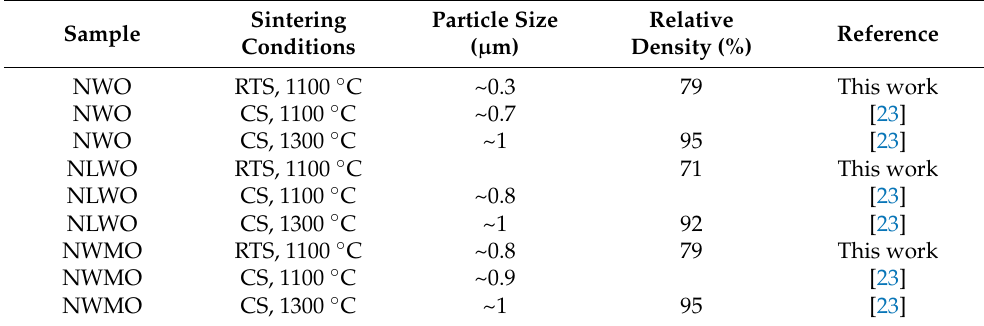
Table 2. Morphological characteristics of the samples obtained by mechanical activation and sintered using electron beams (RTS) and conventional sintering (CS) [23].